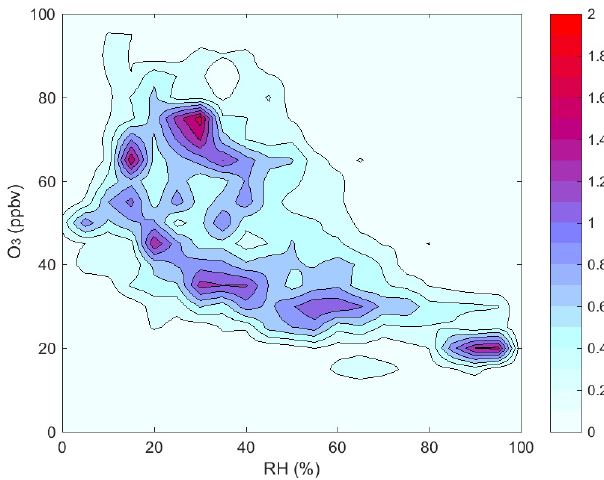
Figure 4. Two-dimensional distribution of ozone (in ppbv; 20 classes between 0 and 100ppbv) and relative humidity (in %; 20 classes between 0% and 100%) from 4 to 12km altitudes for 56 vertical profiles derived from IAGOS measurements during take-off from and landing to TPE at less than 1200km from the centres of tropical storms and typhoons Nepartak, Nida, Meranti, Megi, Sarika and Haima during July to October 2016.